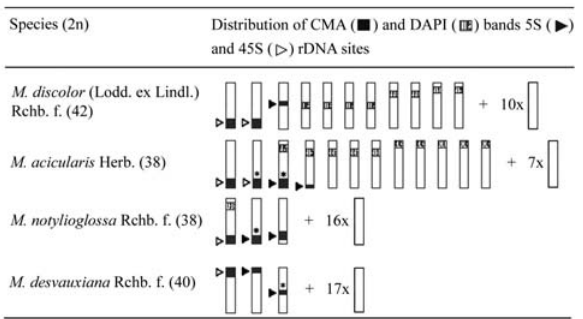
Figure 2 - Chromosomal distribution of heterochromatic bands and 5S and 45S rDNA sites in the haploid chromosome complement of four Maxillaria species. Centromere position and chromosome size are not in- dicated, but the chromosomes are represented with the long arms at the bottom. Therefore, all chromosome bands in or close to the top are proxi- mal bands of acrocentric chromosomes. Wherever band-size heteromor- phism was observed (indicated by an asterisk) only the largest band variant was